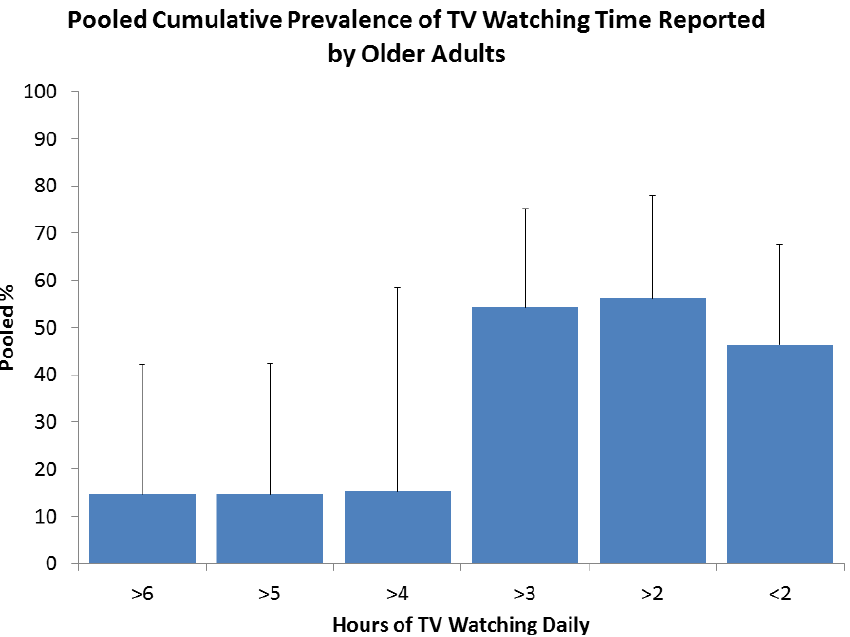
Figure 4. Prevalence of sitting watching TV, N = 275,344 older adults, n = 9, note the sum of <2 h (44%) and >2 h (56%) is equal to